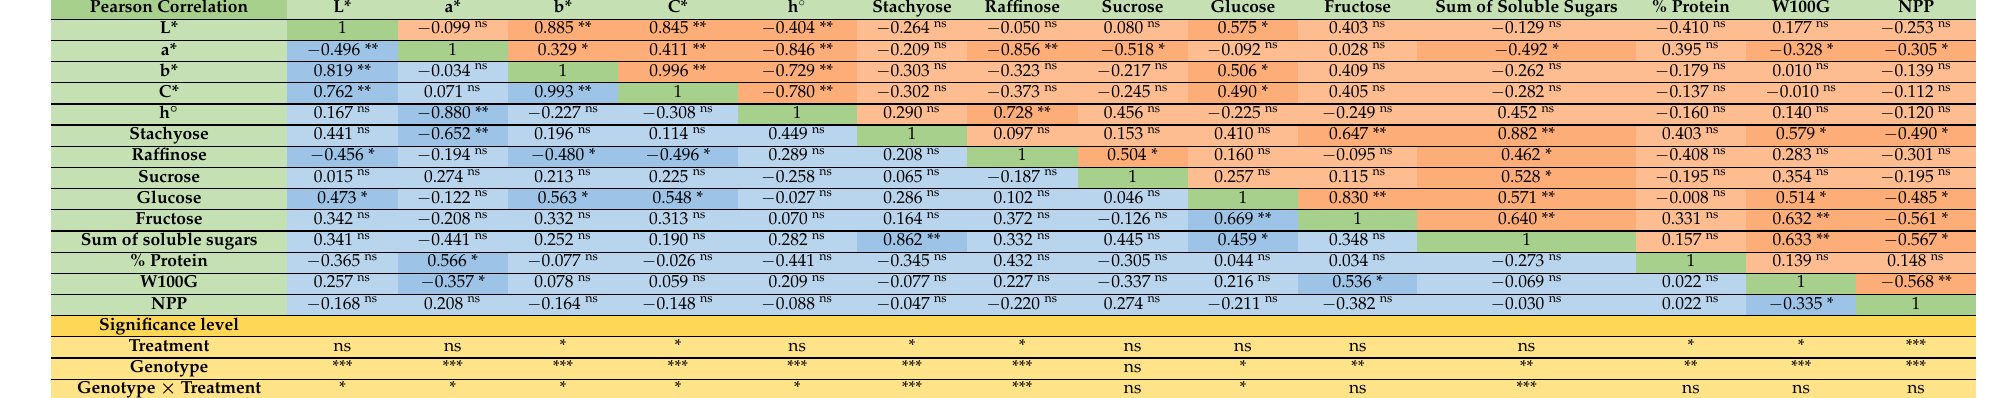
Table 6. Pearson correlation values and significance level of treatment, genotype, and their interaction on grain quality parameters. Pearson